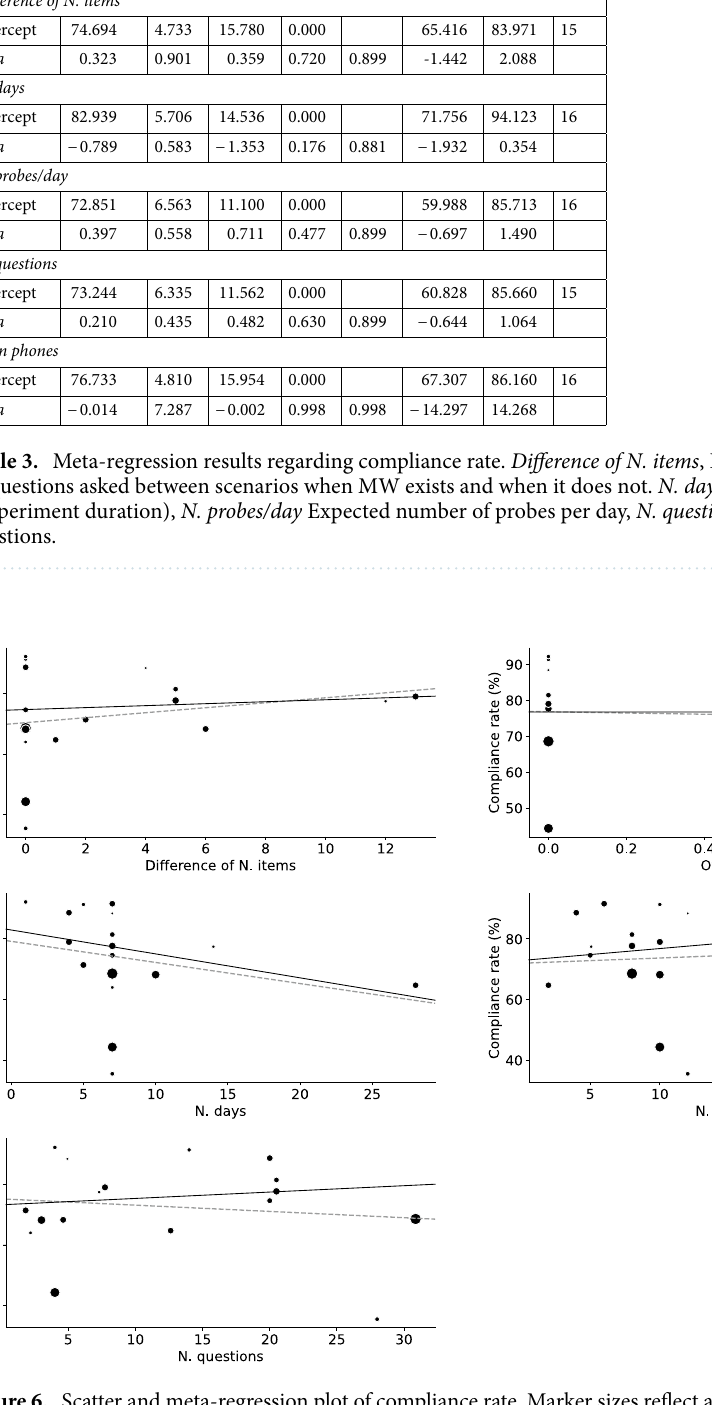
Figure 6. Scatter and meta-regression plot of compliance rate. Marker sizes reflect article sample sizes. The solid line is the meta-regression line biased by article weights. The dashed line denotes the unweighted regression line. N. days Number of days (Experiment duration), N. probes/day Expected number of probes per day, Sub. exclusion rate (%) Rate of excluded subjects to recruited subjects, Thr. of compliance (%) Threshold of compliance rate (only if authors used compliance rate as a criterion of subject exclusion), N. questions not when MW Expected number of questions if MW does not exist, N. questions when MW Expected number of questions if MW